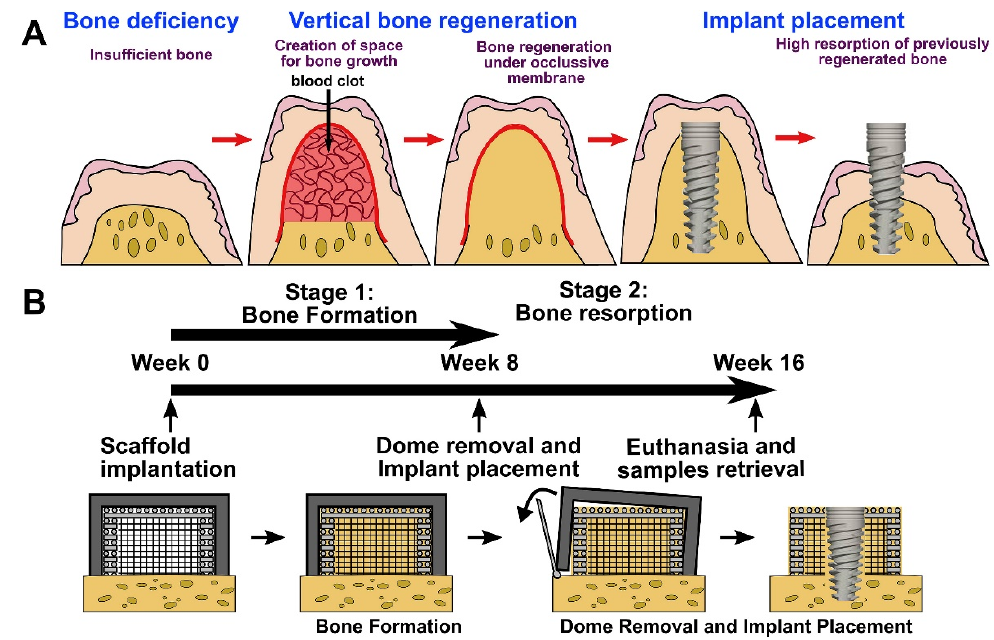
Figure 5. Vertical bone augmentation with a 3D printing approach. ( A ) Description of the clinical problem following surgical re-entry in previously elevated bone, resulting in significant bone resorption. ( B ) Timeline of the experimental approach involving a two-staged strategy; bone formation following surgical re-entry and implant placement [136]. Copyright 2021 Elsevier.